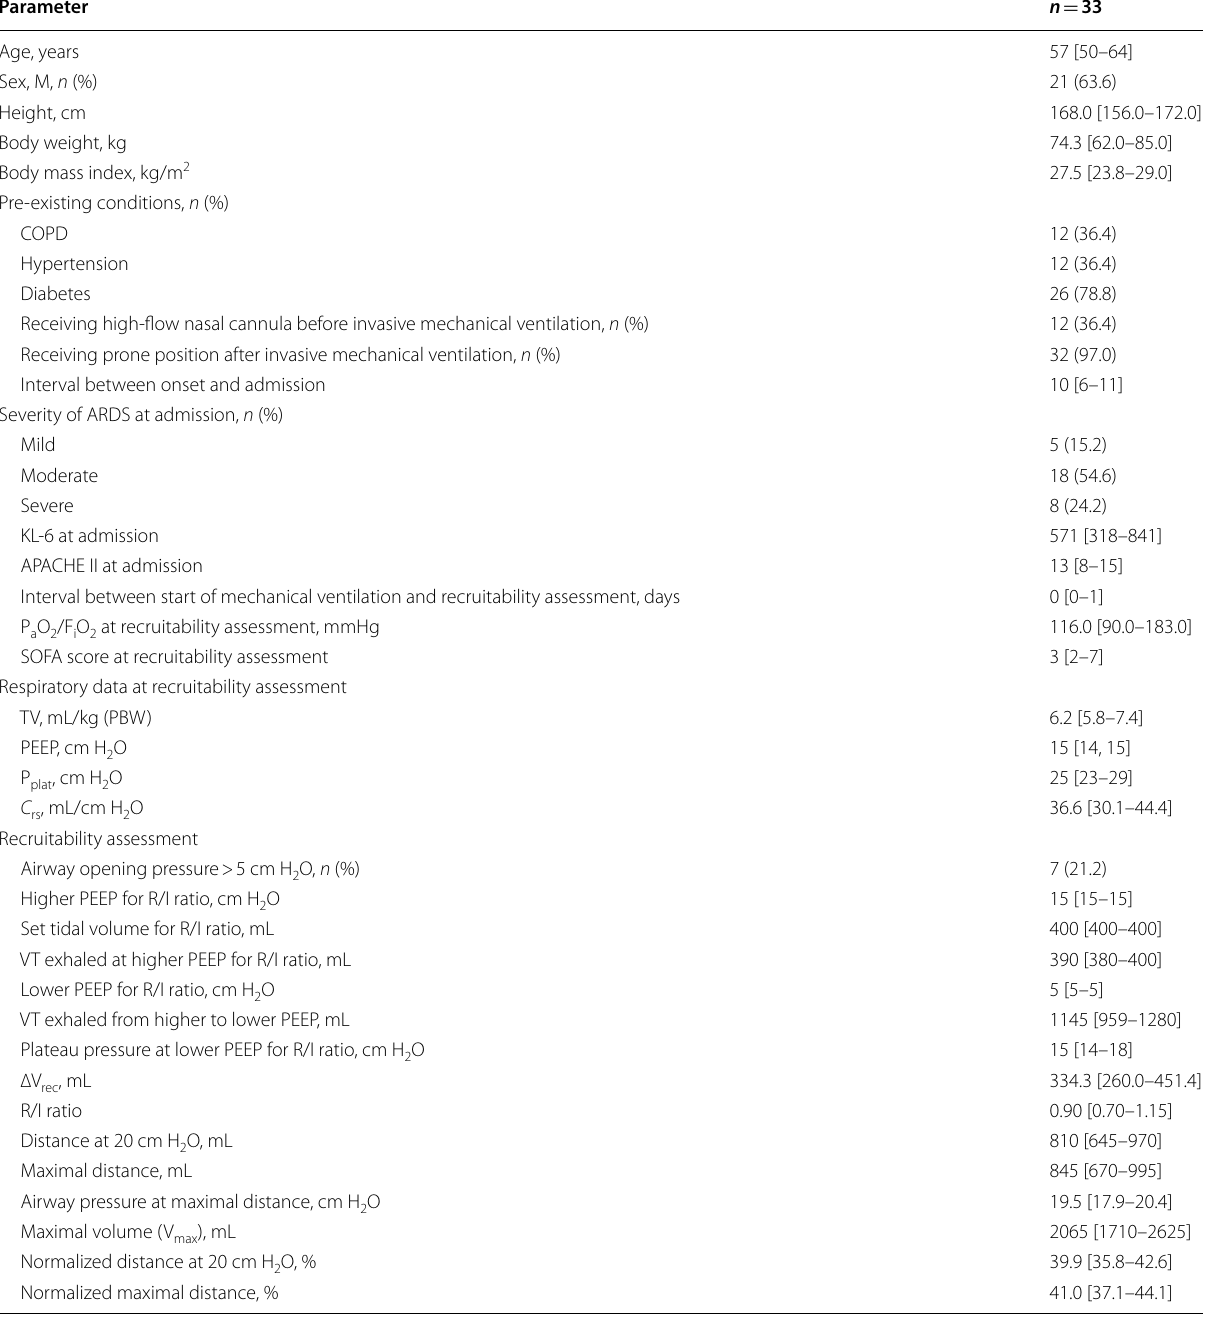
Table 1 Patient characteristics, respiratory mechanics, and recruitability